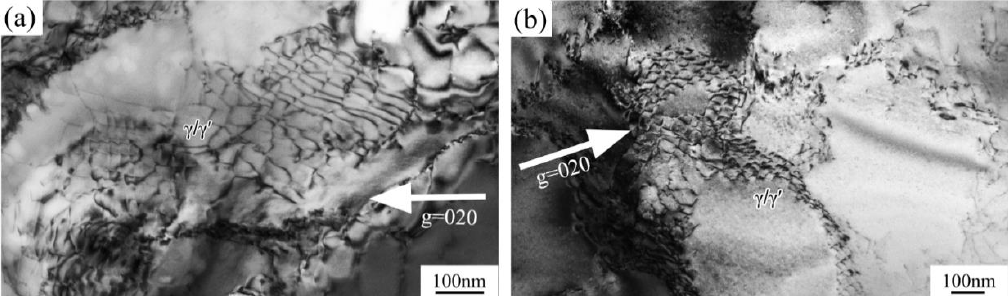
Figure 7. TEM images of deformation microstructures at high temperatures: ( a ) 1000 °C; ( b ) 1100 °C.